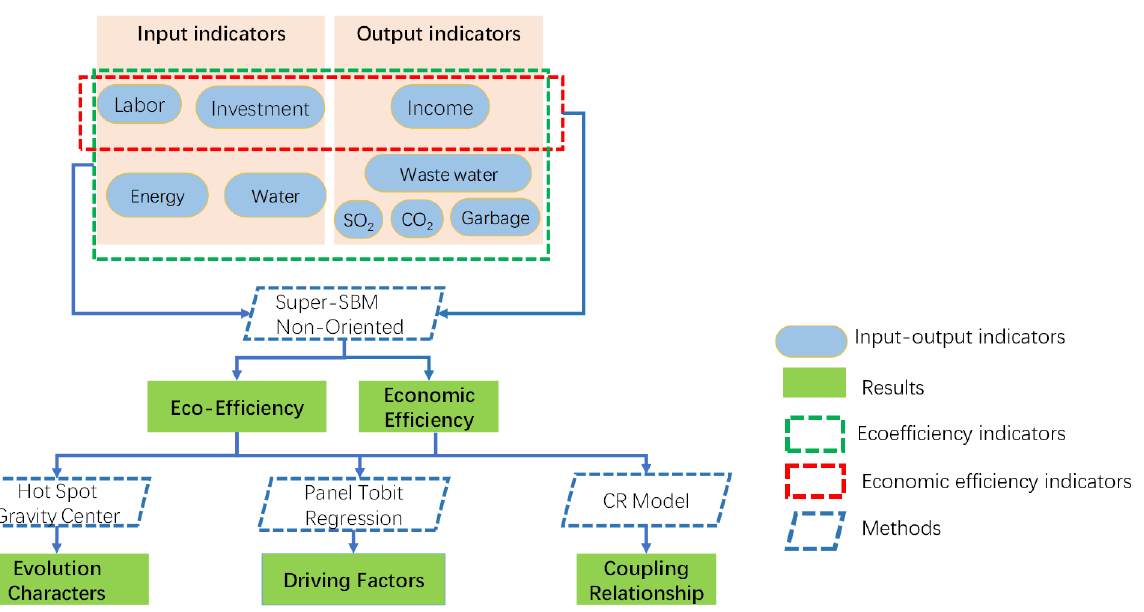
Figure 2. The analysis method of efficiency and eco-efficiency: Super-SBM Non-Oriented.